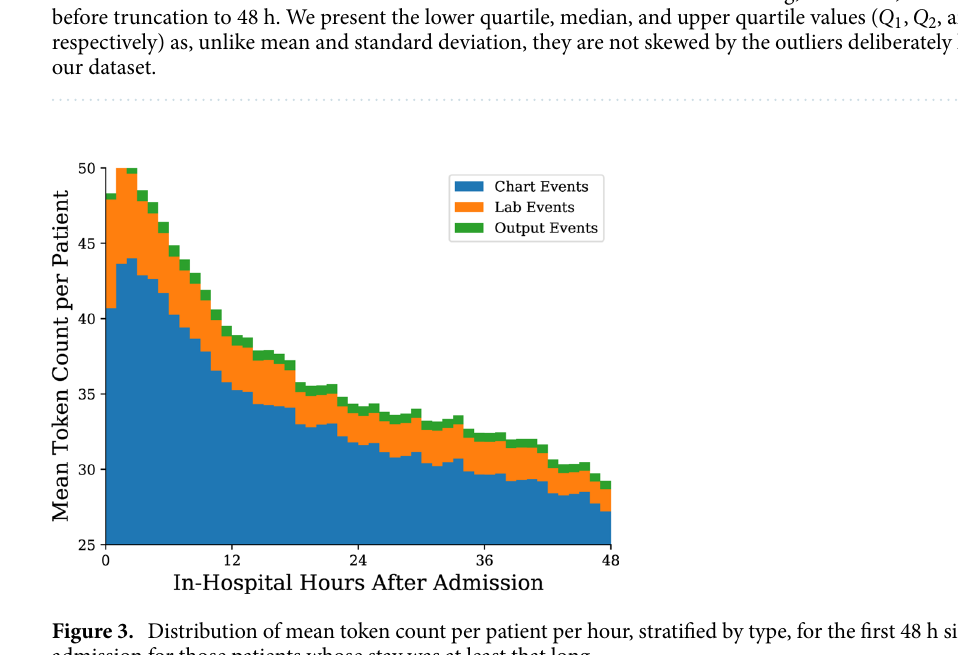
varying the number of percentile bins used to discretise continuous values in Fig. 5b. We find 10 bins offers the best performance of the three variants tested, providing the best trade-off between broad outlier categories and delineation of densely packed distributions. For predicting inpatient mortality, the AUROC curve at 48 h after admission was 0.8463 (95% CI 0.8411–0.8513, bootstrapped from 10,000 samples of a 10-fold cross-validation). This was significantly stronger